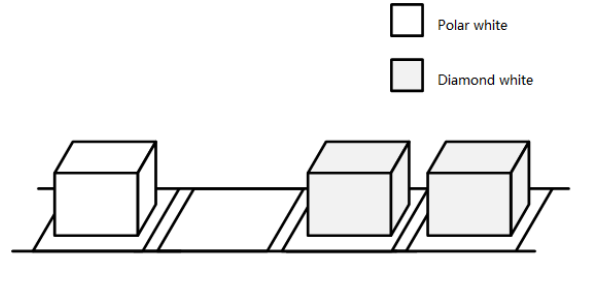
Figure 8. Arrangement of polar white and diamond white.